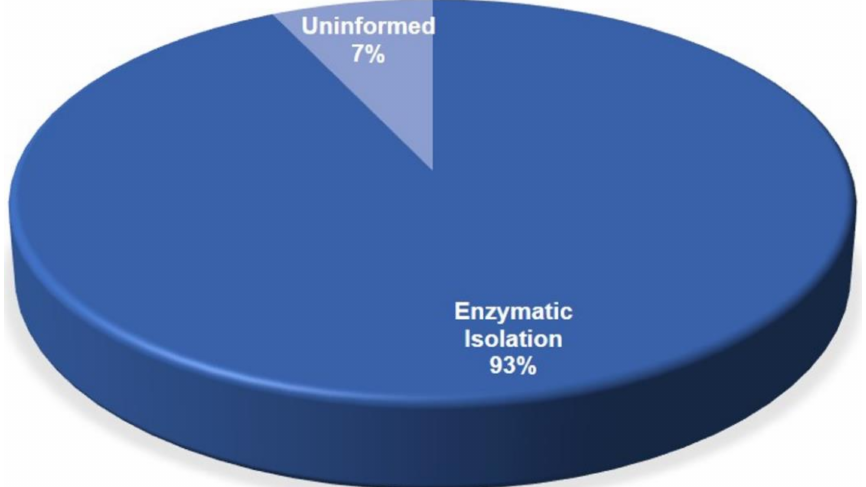
Figure 7. Isolation methodology of AD-MSC.